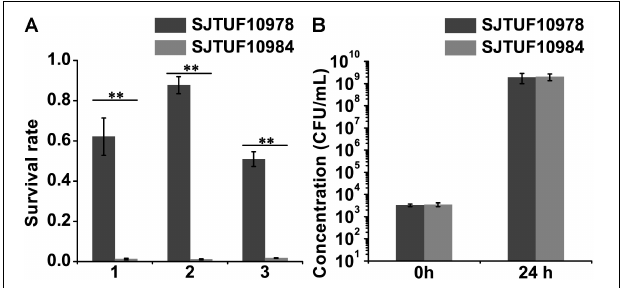
FIGURE 1 | Survival of Salmonella Enteritidis strains SJTUF10978 and SJTUF10984 in egg whites. (A) The survival rate represents the ratio of surviving number of bacteria after 24-h incubation to the 0-h incubation in egg whites at 37 ◦ C. Results from three experiments performed in triplicate for each were shown. After incubation, SJTUF10978 displayed significantly higher survival rates than SJTUF10984 with 62.1:1.3, 87.7:1.1, and 50.9:1.8%, respectively, in three experiments using the egg whites from different patches of SPF eggs. (B) Growth in LB as control. The means ± standard deviations of results from three experiments performed in triplicate for each were shown. ∗∗ p < 0.01, two-tailed t -test.